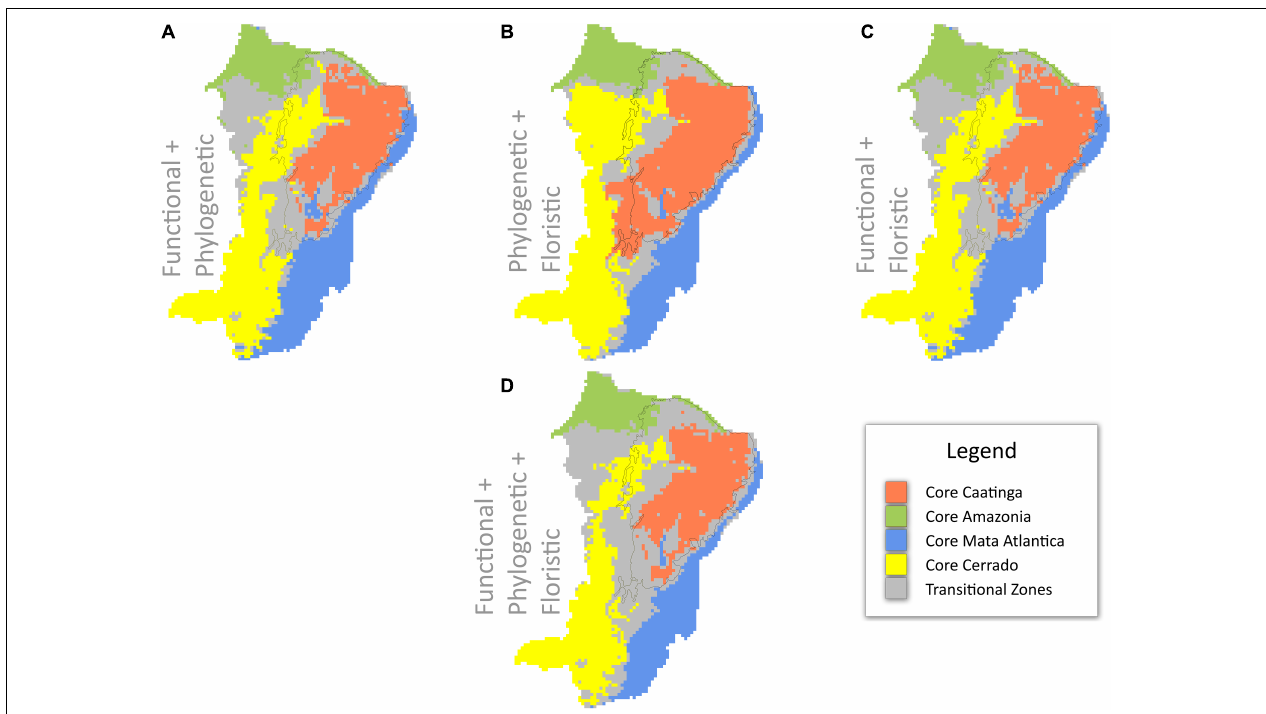
FIGURE 3 | Areas of agreement and disagreement among biome delimitations across northeast Brazil based upon hierarchical clustering analyses of functional, phylogenetic, and floristic data alone (see Figures 2A–C ). Areas of agreement are shown as “core” clusters (A–C) or biomes (D) and areas of disagreement are shown as “transitional zones.” (A) functional and phylogenetic data; (B) phylogenetic and floristic data; (C) functional and floristic data; and (D) functional, phylogenetic, and floristic data. The black line indicates the limits of the Caatinga domain sensu Instituto Brasileiro de Geografia e Estatística (IBGE) (2012). Alternative plots showing the identity of transitional zones are given in Supplementary Figure 4